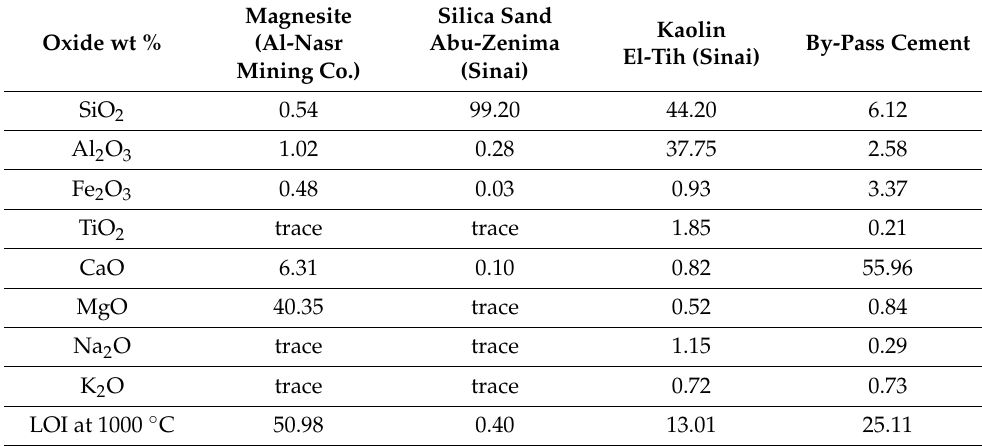
Table 1. Chemical analyses of raw materials used in the batch preparation.